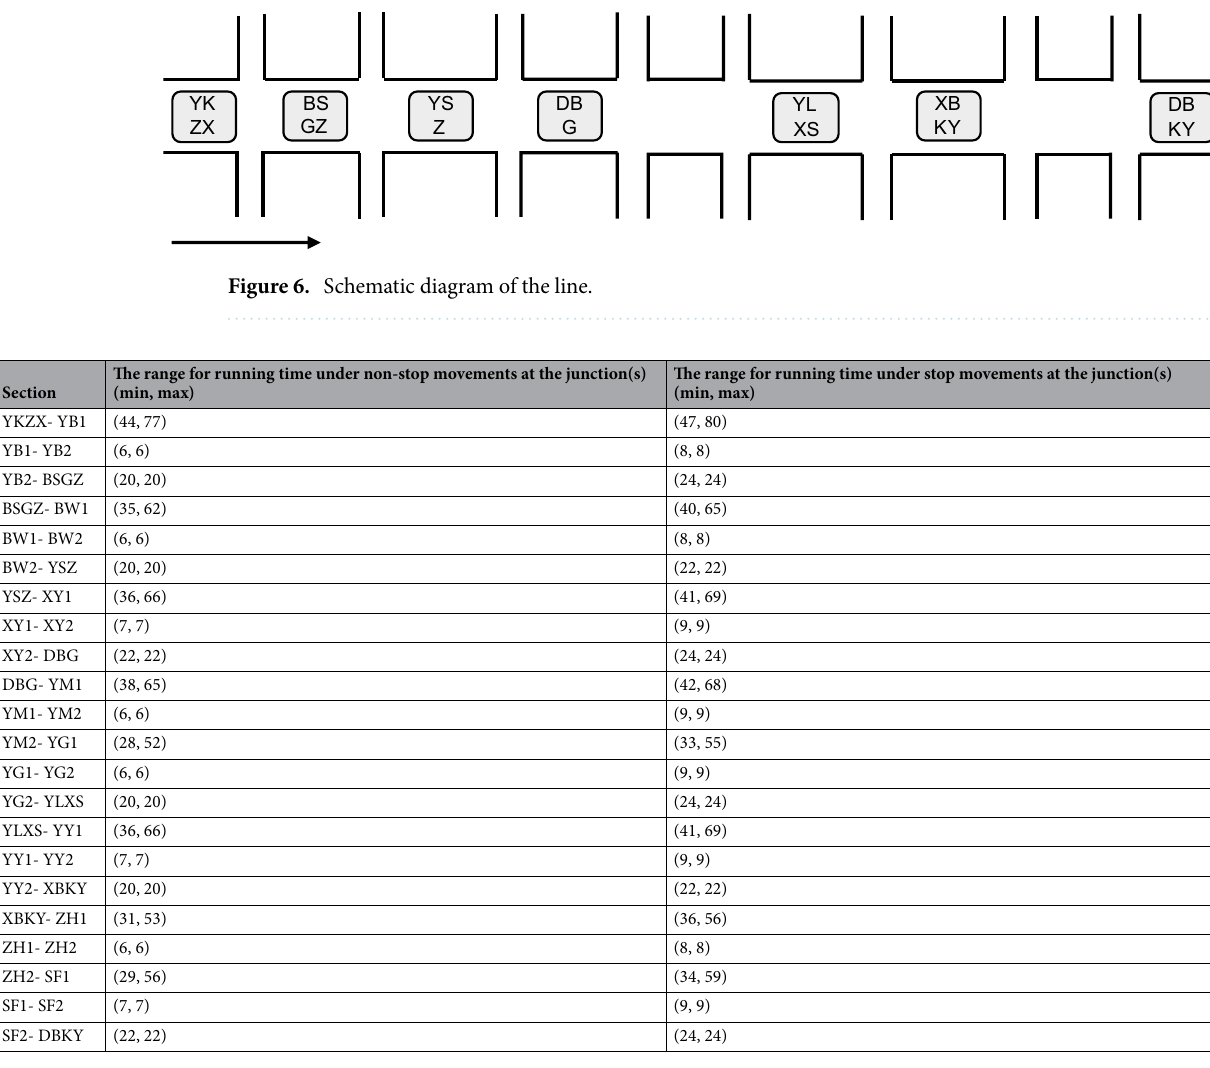
Table 2. The range for section running